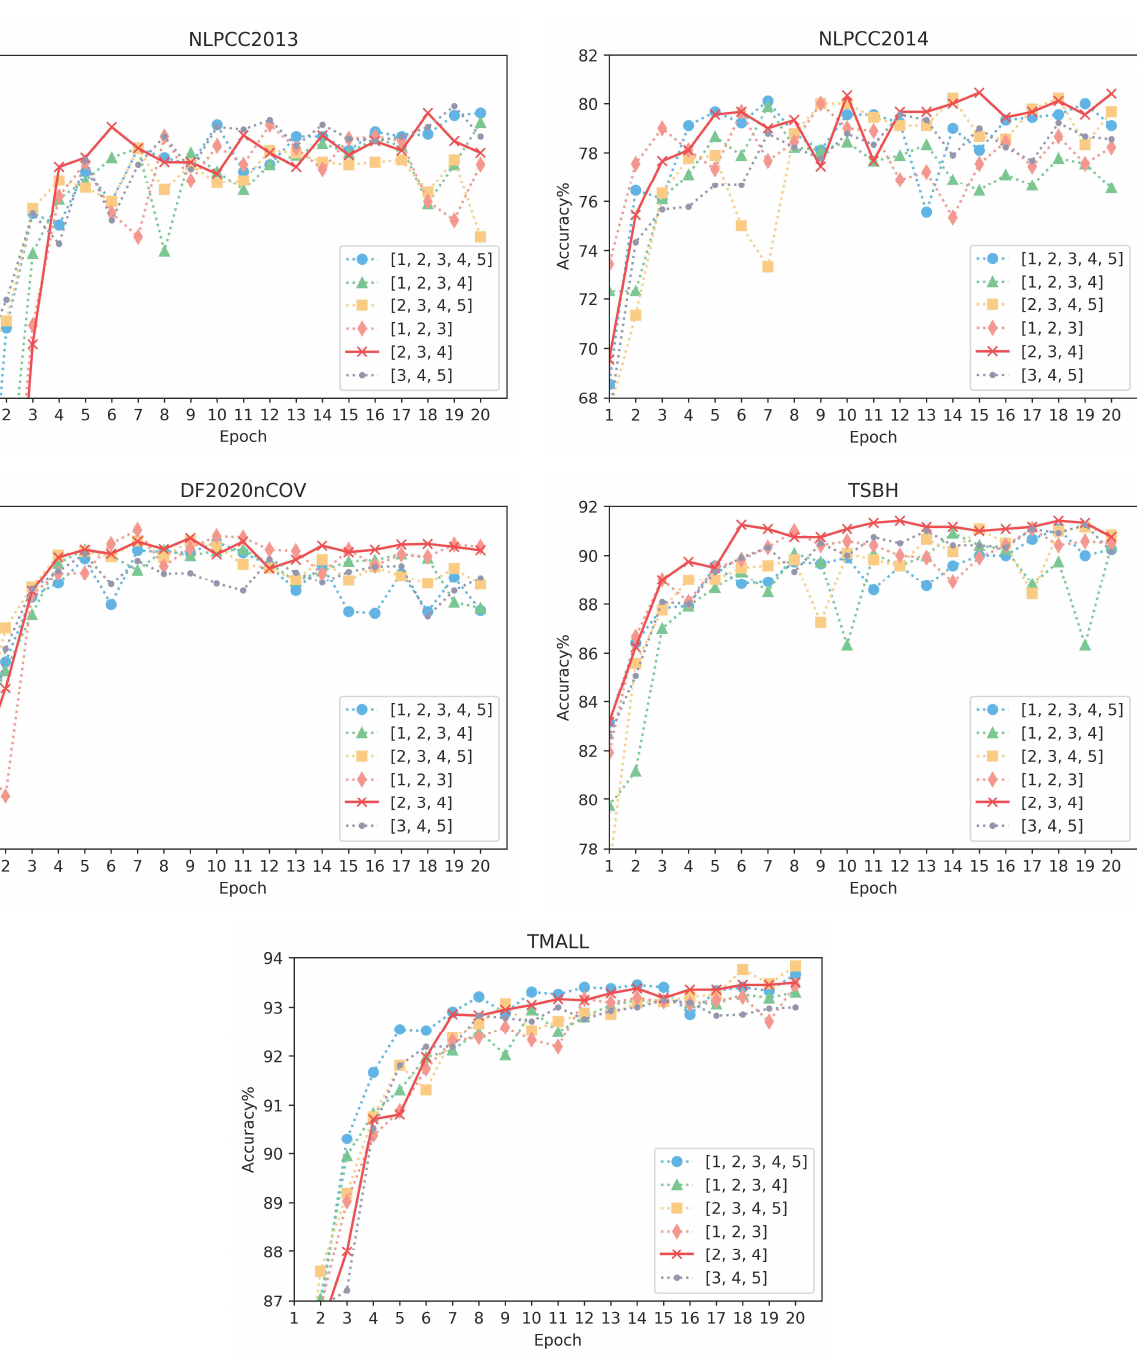
Figure 2. Sensitivity analysis for different granularity combinations on characters. These figures show the performance of the multi-grained feature layer using six combinations with twenty rounds trained on five datasets for each granularity choice.